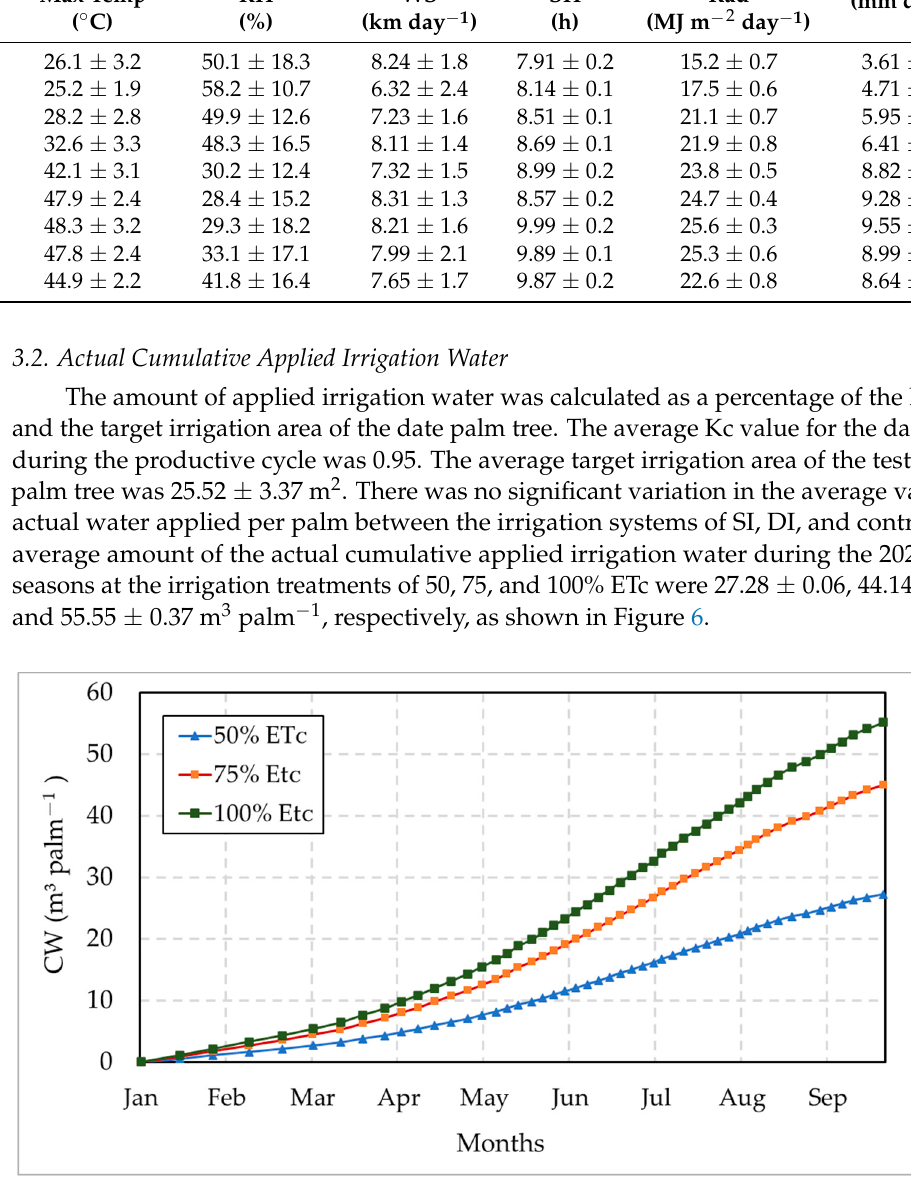
Figure 6. The average amount of the actual cumulative applied water (CW) per palm under the various irrigation treatments of 50, 75, and 100% ETc during the 2020–2021 seasons.